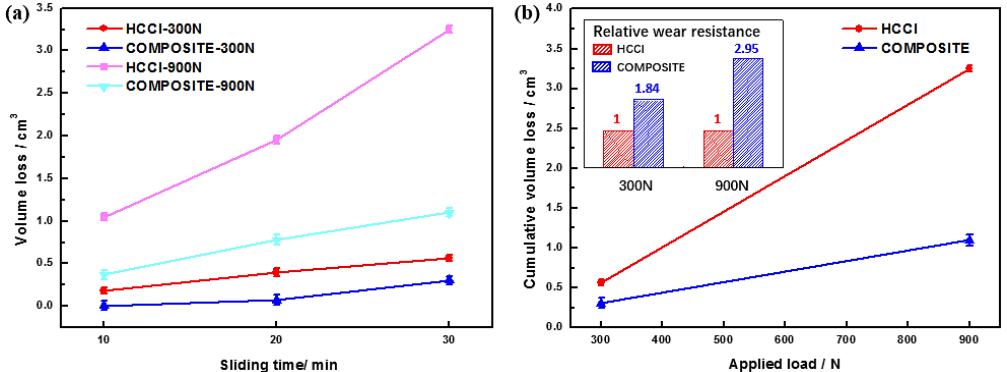
Figure 7. ( a ) The volume loss of as a function of sliding time under di ff erent loads; ( b ) the relation of cumulative volume loss and applied load and the relative wear resistance of the composite to HCCI.